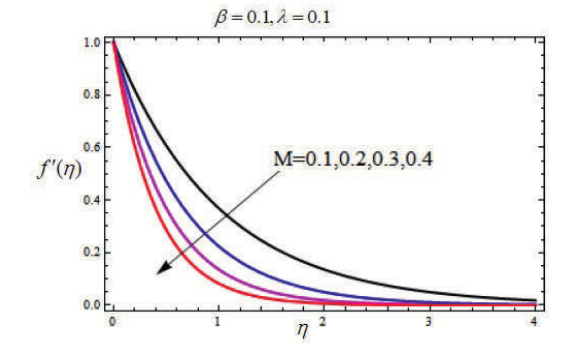
Fig. 5: Variation of velocity f (cid:3) ( η ) with η for several values of Mag- netic parameter M .